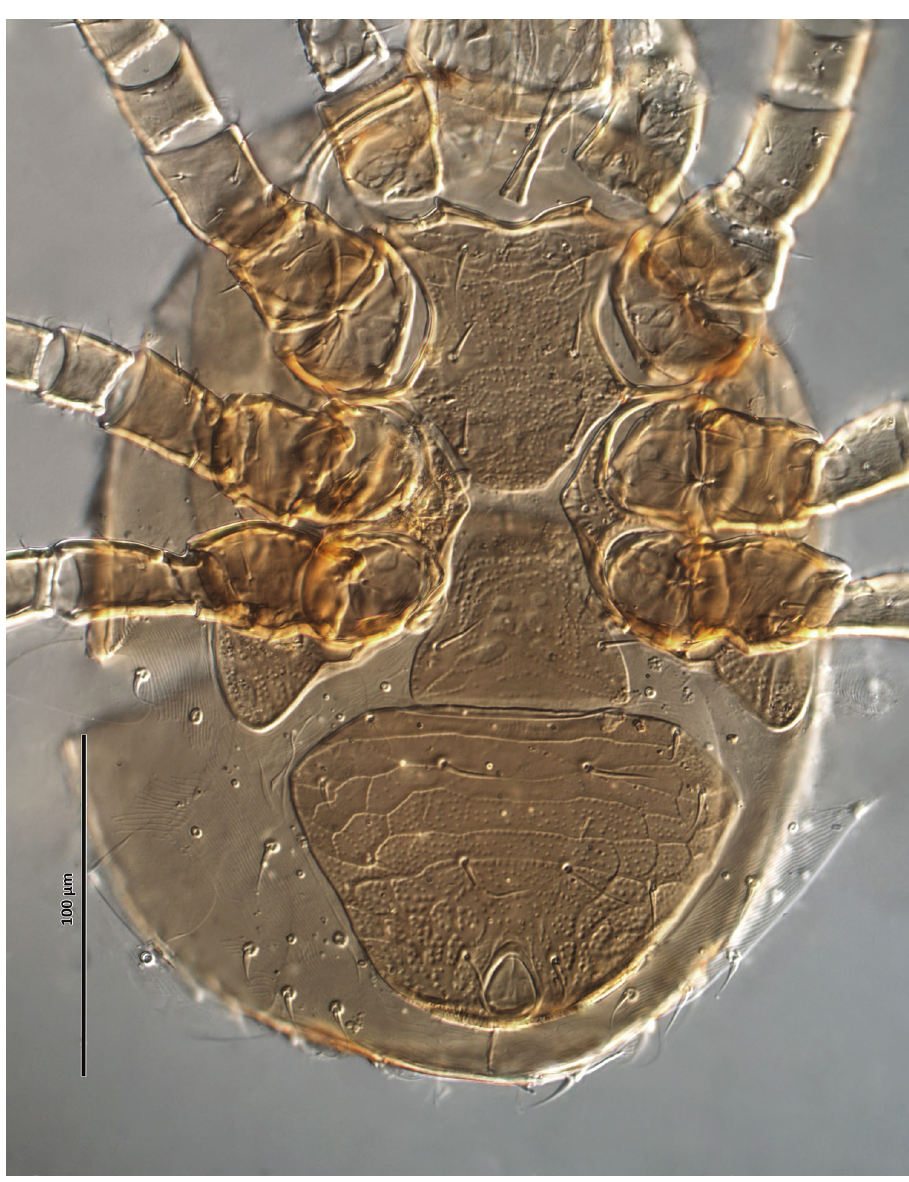
Figure 29. Zygoseius papaver sp. n., female, ventral idiosoma. for other gamasines. We have examined adult specimens of other Zygoseius spp., as well as of Pachylaelaps (Pachylaelapidae), Gaeolaelaps (Laelapidae), Asca (Ascidae), Proctolaelaps (Melicharidae), Parasitus and Pergamasus (Parasitidae), and the dorsal seta of trochanter I was usually inserted in a slightly to moderately posterior position, and rarely on the mediodorsal line or in a (slightly) anterior